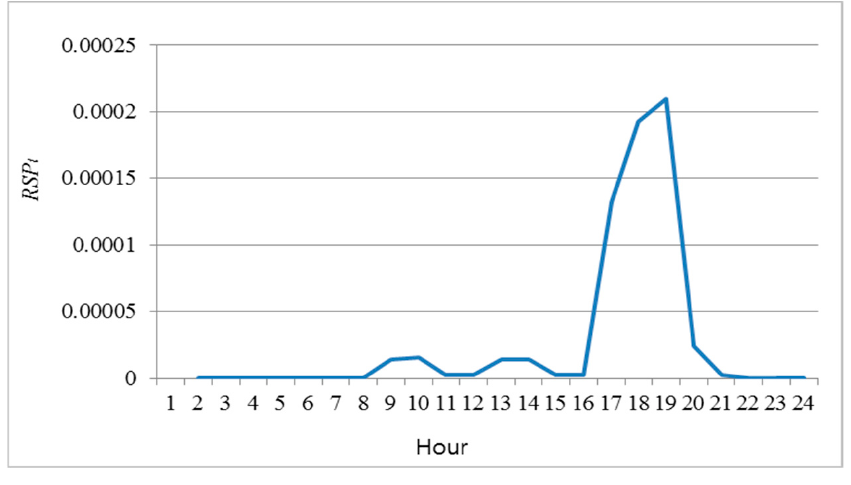
Figure 6. Hourly RSP t. Table 4. Scenario for three parameters: FNL, skewness ( P sk ), kurtosis ( P k ).